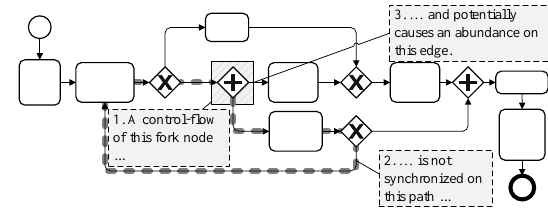
Figure 28. Detailed feedback for a fault where a fork node can generate any number of 2